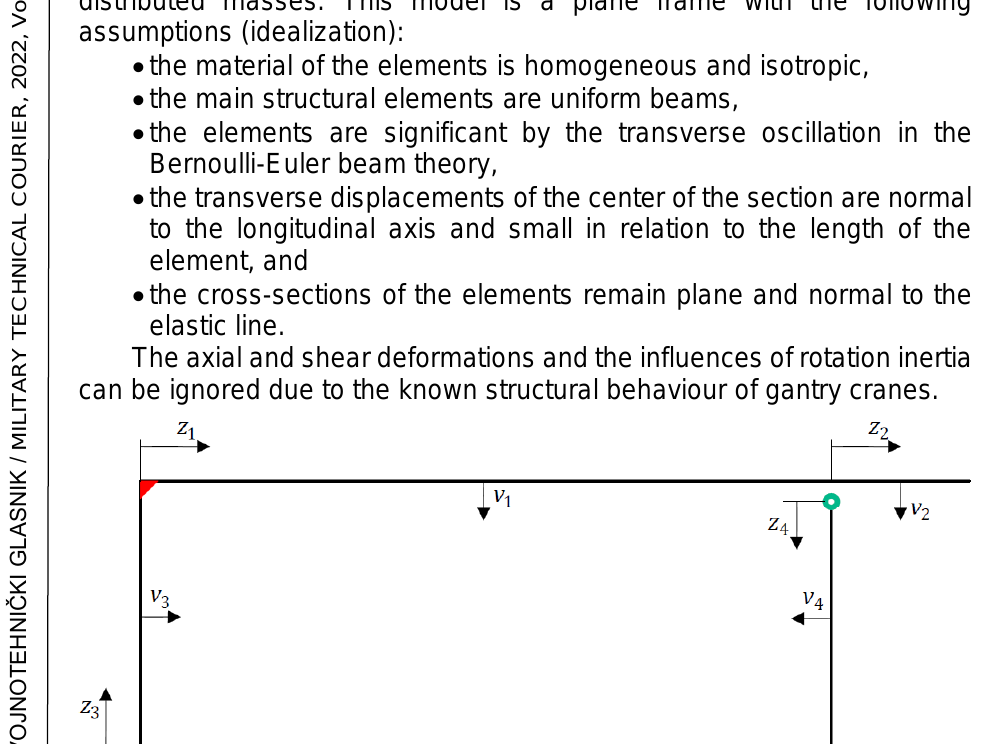
Figure 3 – Continuous model Рис. 3 – Непрерывная модель Слика 3 – Континуални